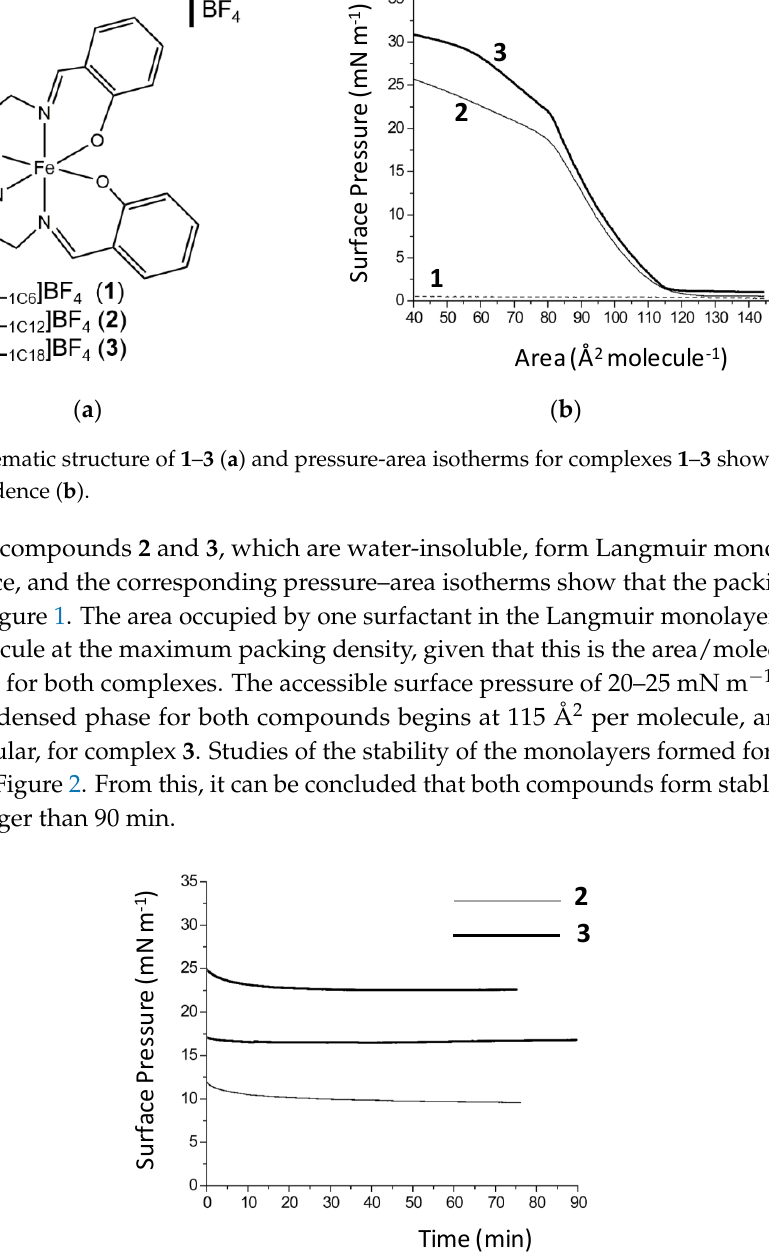
Figure 2. Time-dependence of film stability for complexes 2 and 3 at a fixed barrier position. The stability of complex 3 was measured at two different surface pressures.